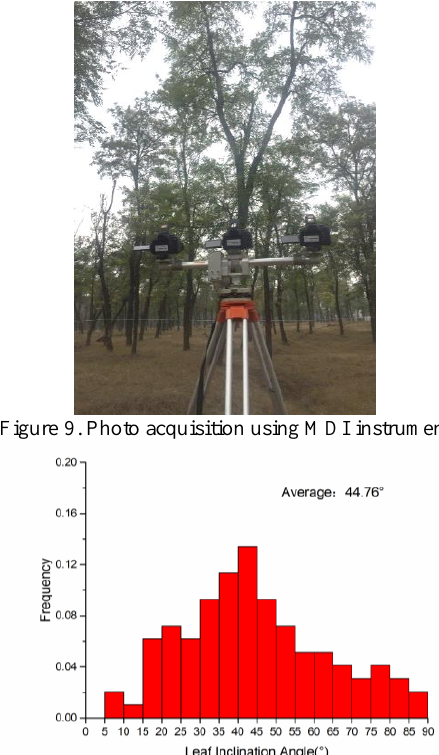
Figure 10. MDI-based LAD histogram of the actual tree In this study, Riegl VZ-1000 was used for the acquisition of the TLS point cloud and the parameters were the same as used in Chapter 3.1. Figure 11 showed the point cloud of the broadleaf tree.